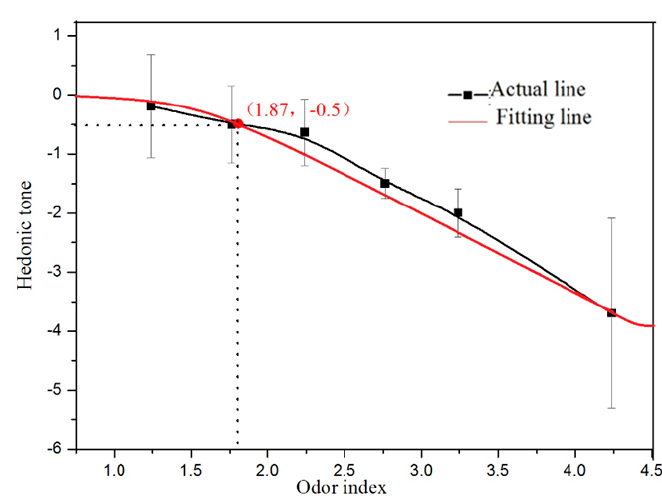
Figure 3. The behavior curve of butyl acetate.